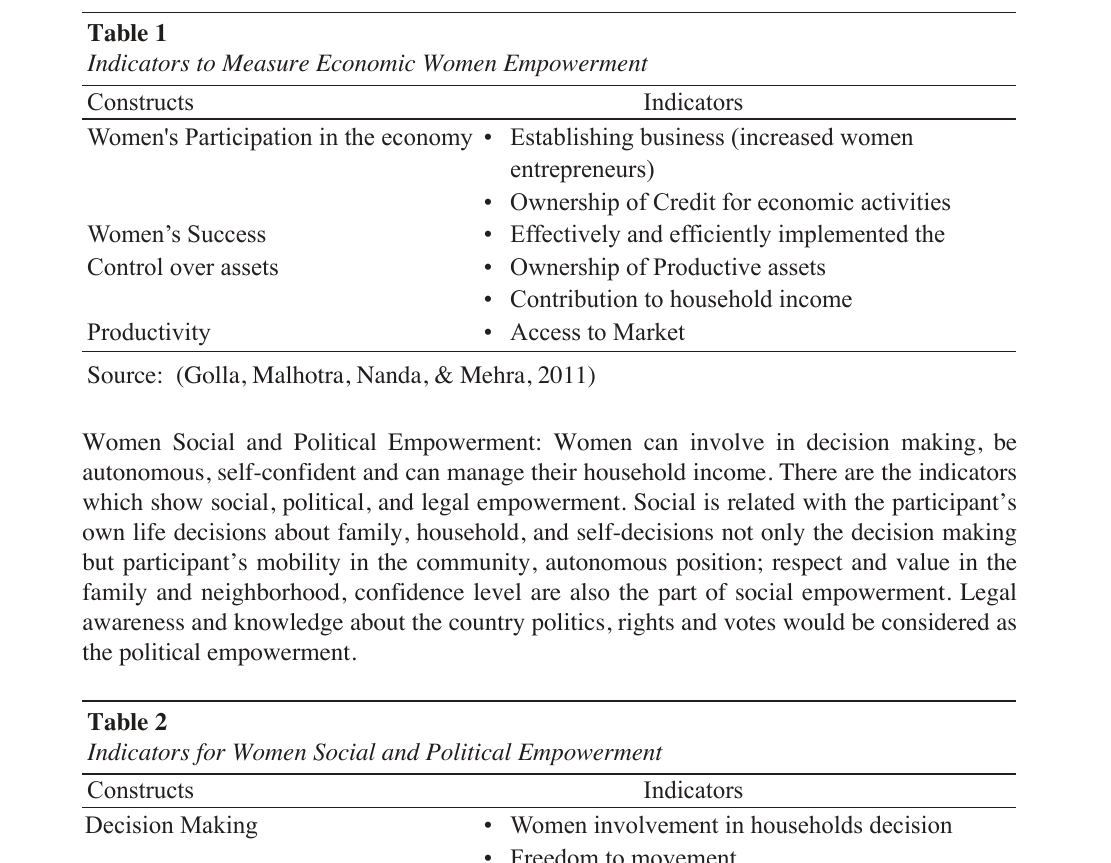
Indicators to Measure Economic Women Empowerment